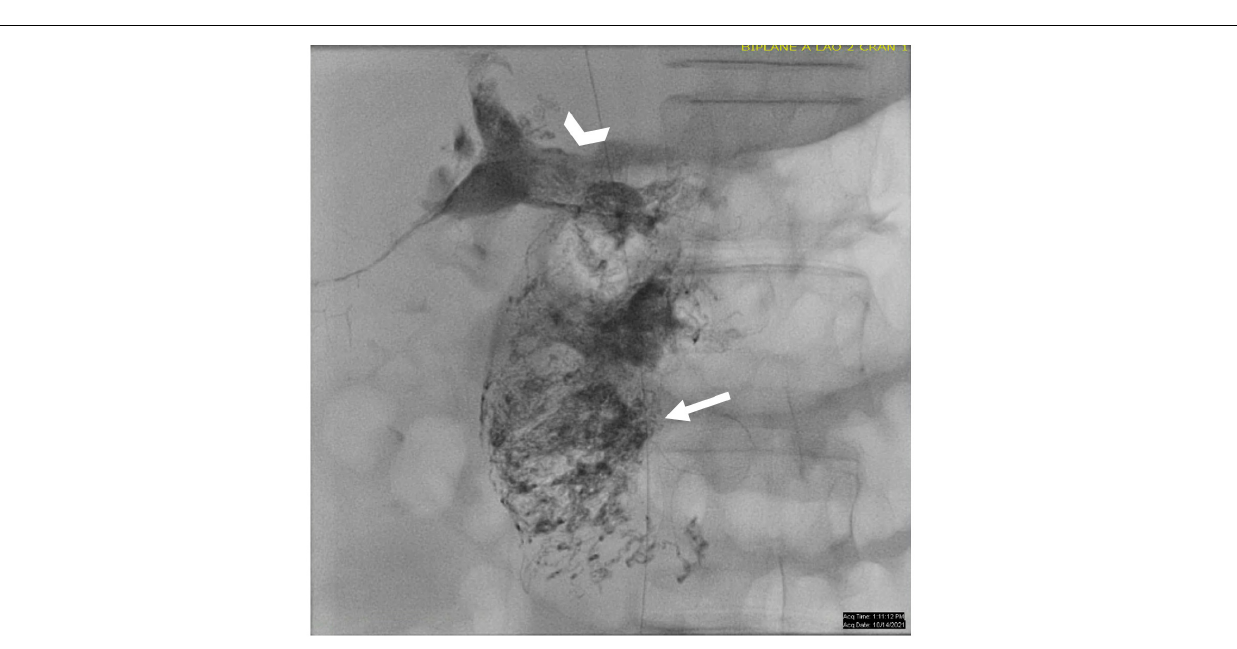
FIGURE 9 | AP fluoroscopic image of the duodenum after periduodenal (arrow) and hepatoduodenal (arrowhead) lymphatic